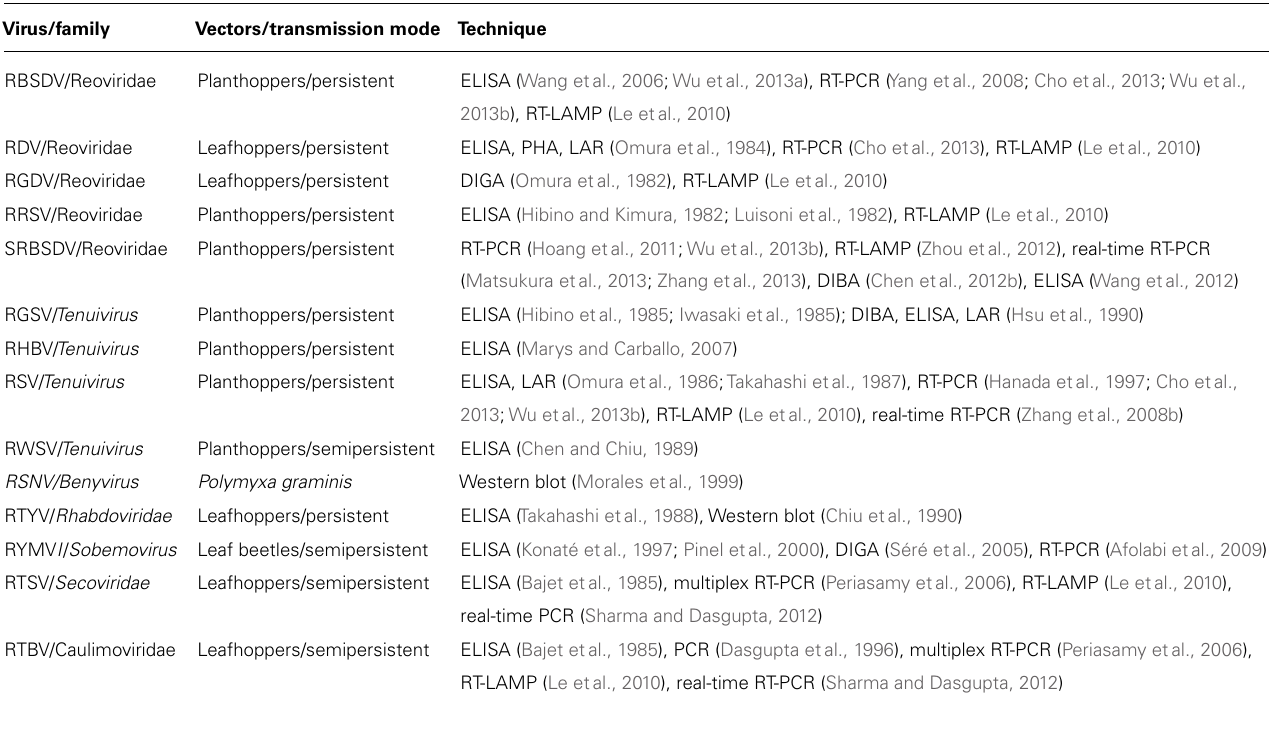
Table 1 | Overview of detection methods for viruses in rice plants and in insect vectors.